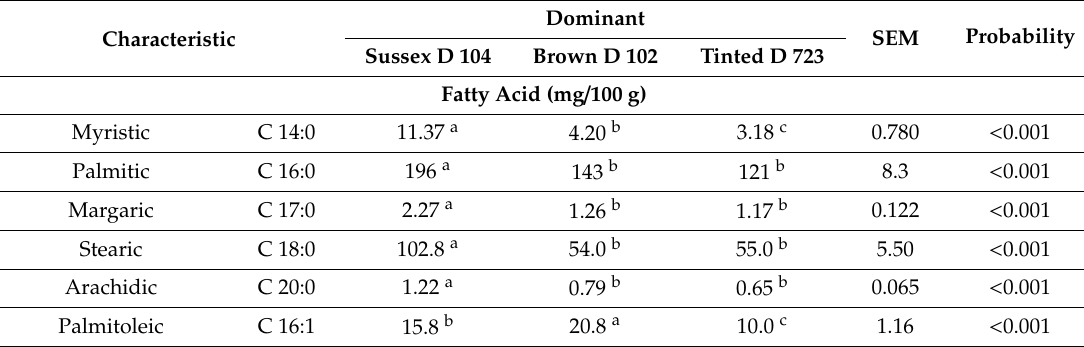
Table 6. Composition and indexes of fatty acids, fat content and cholesterol content in breast